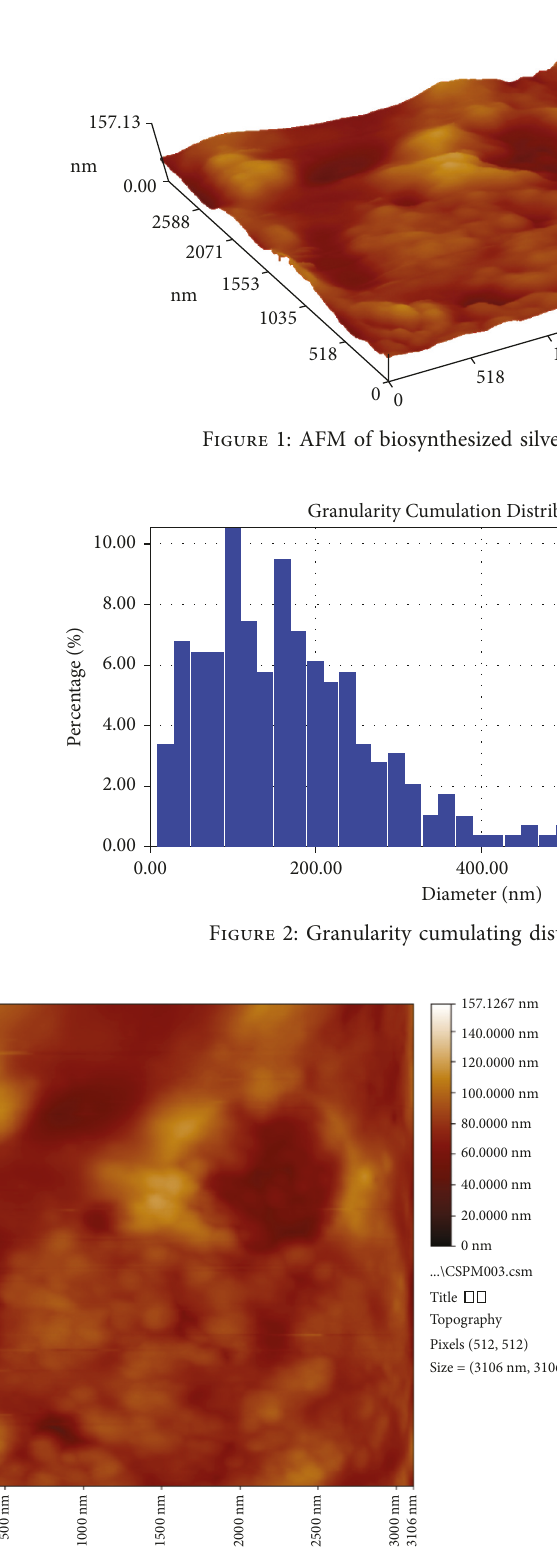
Figure 3: AFM image surface roughness